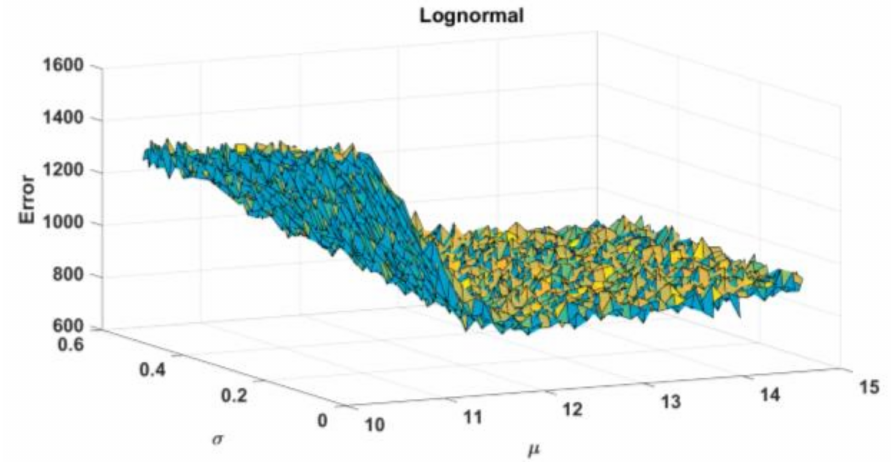
Figure 16. Validation error (Lognormal): Error—the value of the error, σ —the sample variance, µ —sample mathematical